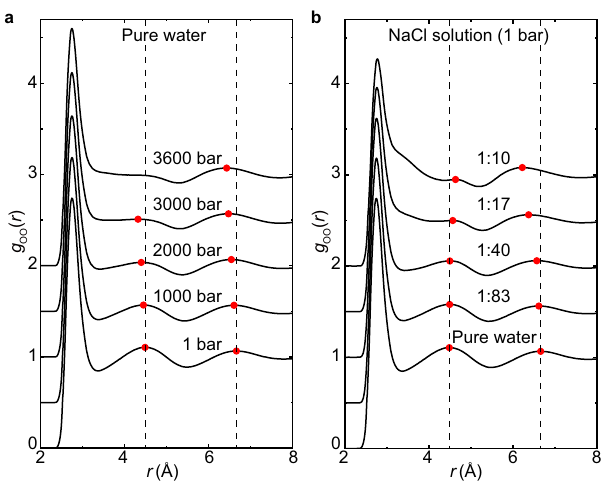
Fig. 2 Real-space structures of pure water and NaCl solutions. a Calculated O – O radial-distribution function, g oo r ð Þ , of pure water at different pressures. b Calculated g oo r ð Þ of NaCl solutions for different concentrations at 1 bar. All RDFs were shifted vertically for visual clarity. The red dots indicate second and third peak positions; vertical dashed lines are for pure water at 1